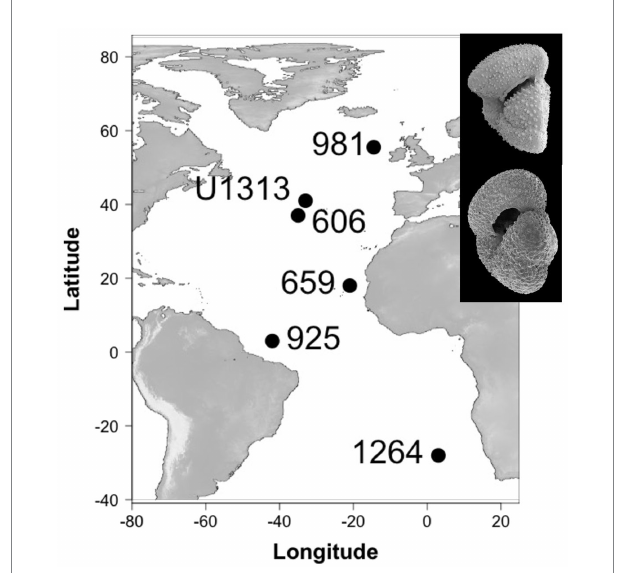
FIGURE 1 Study site locations and study species (inset, top: Truncorotalia crassaformis , bottom: Globoconella puncticulata